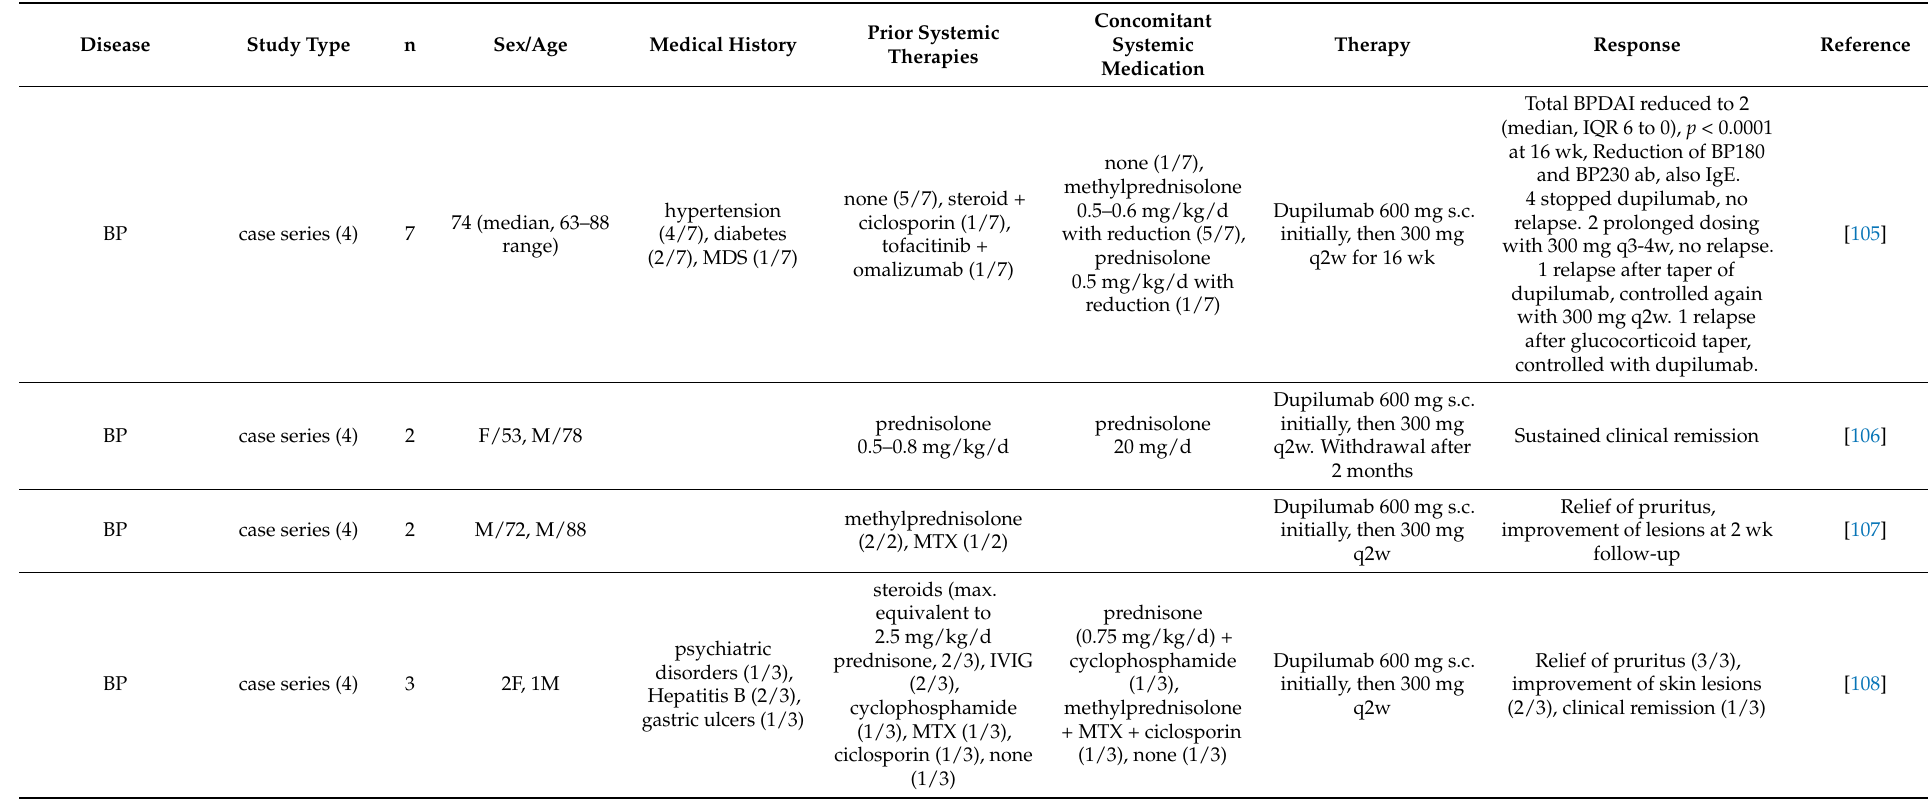
Table 3. Bullous and acantholytic